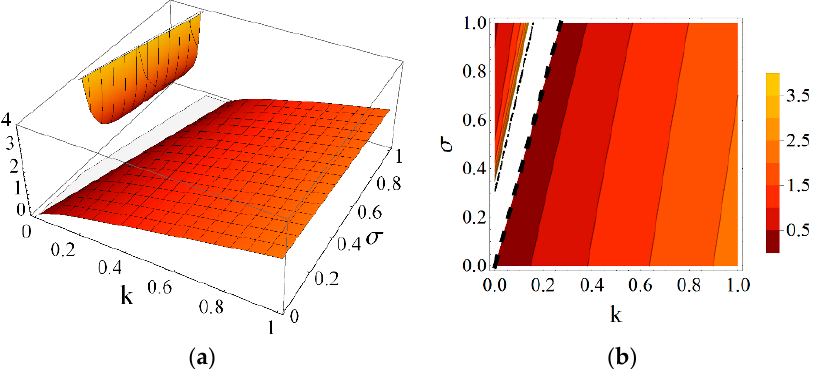
Figure 6. Young’s modulus E 1 (divided by the factor EA / a 2 ) with the limiting condition E 1 > 0: ( a ) three-dimensional (3D) plot; and ( b ) contour plot.